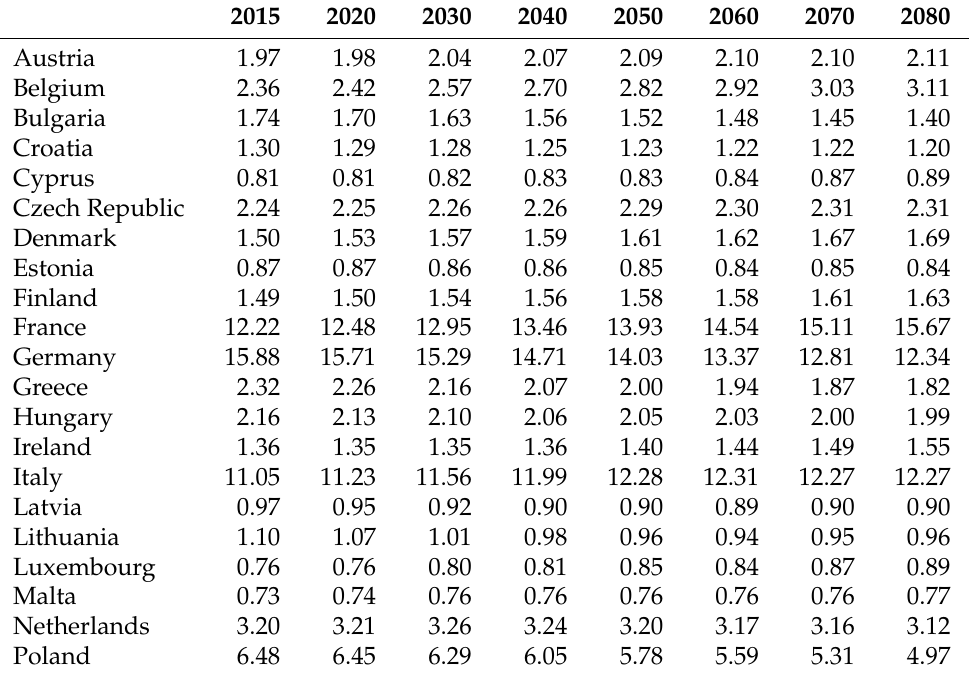
Table A3. Adjusted projections after